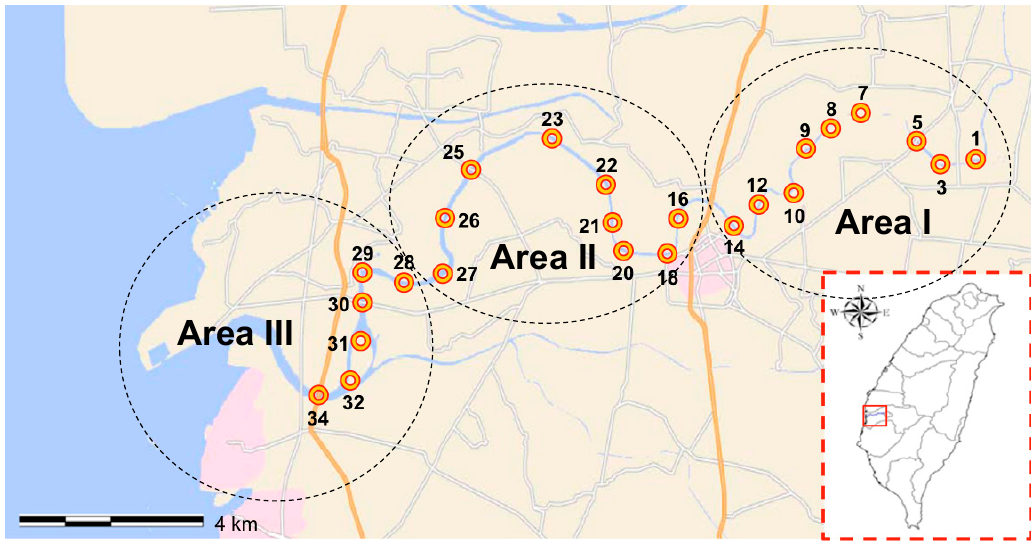
Figure 1. Location of water sampling sites include this study on Puzi River basin, Taiwan.